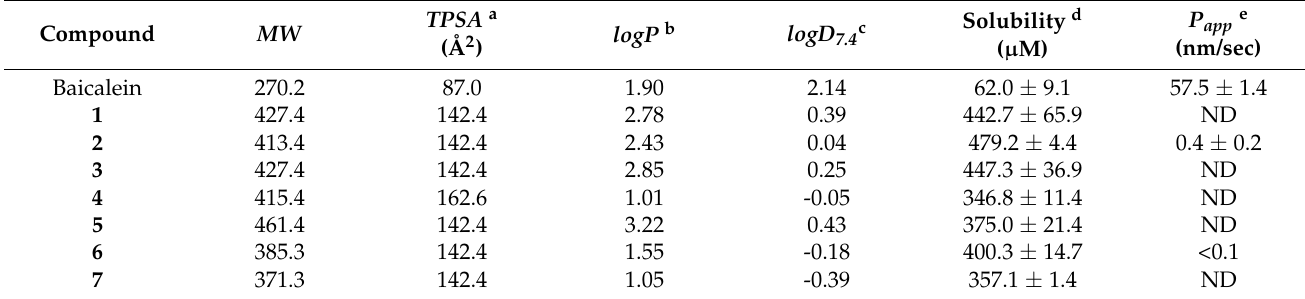
Table 2. Physicochemical properties of baicalein and its carbamate